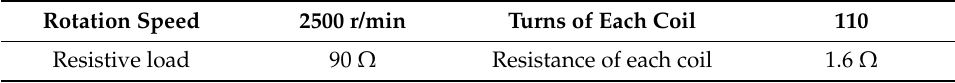
Table 3. Key specifications of the generator with FST-shaped iron